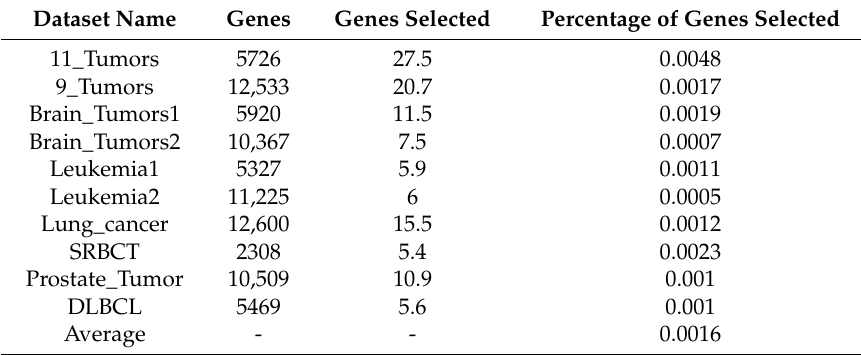
Table 5. The genes, selected genes and percentage of gene selected